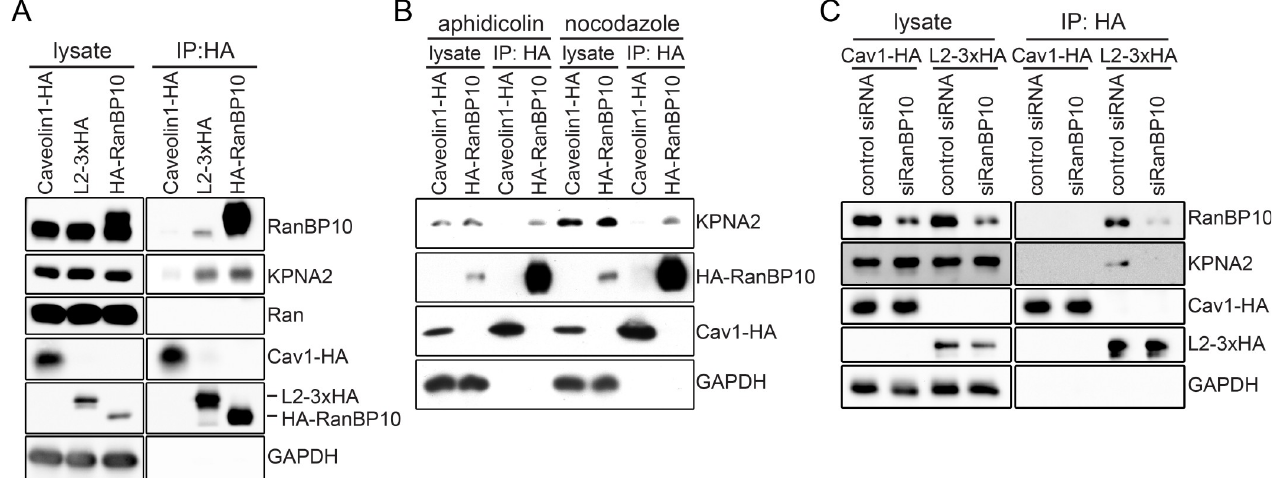
Fig 4. L2 and RanBP10 formed a complex with KPNA2. Immunoprecipitation was used to determine potential interactions between L2, RanBP10 and KPNA2 in HEK293 and HeLa cells. (A) Caveolin1-HA, L2-3xHA or HA-RanBP10 were ectopically expressed in HEK293 cells, and immunoprecipitation against HA was performed on cell lysates. Caveolin1-HA was used as a negative control of immunoprecipitation. Endogenous RanBP10, KPNA2, and Ran were detected by Western blotting after immunoprecipitation. (B) aphidicolin (3 μ M) or nocodazole (330 nM) were used to arrest HEK293 cells ectopically expressing caveolin1-HA, or HA-RanBP10 in interphase or mitosis, respectively. Cell lysates were subjected to immunoprecipitation against HA and endogenous KPNA2 was detected by Western blotting. (C) HeLa cells were transfected with RanBP10 siRNA, followed by ectopic L2-3xHA expression for 24 hours. Cell lysates were subjected to immunoprecipitation against HA. Caveolin1-HA was used as a negative control for HA-tag pull-down. Endogenous RanBP10 or KPNA2 were detected by Western blotting.